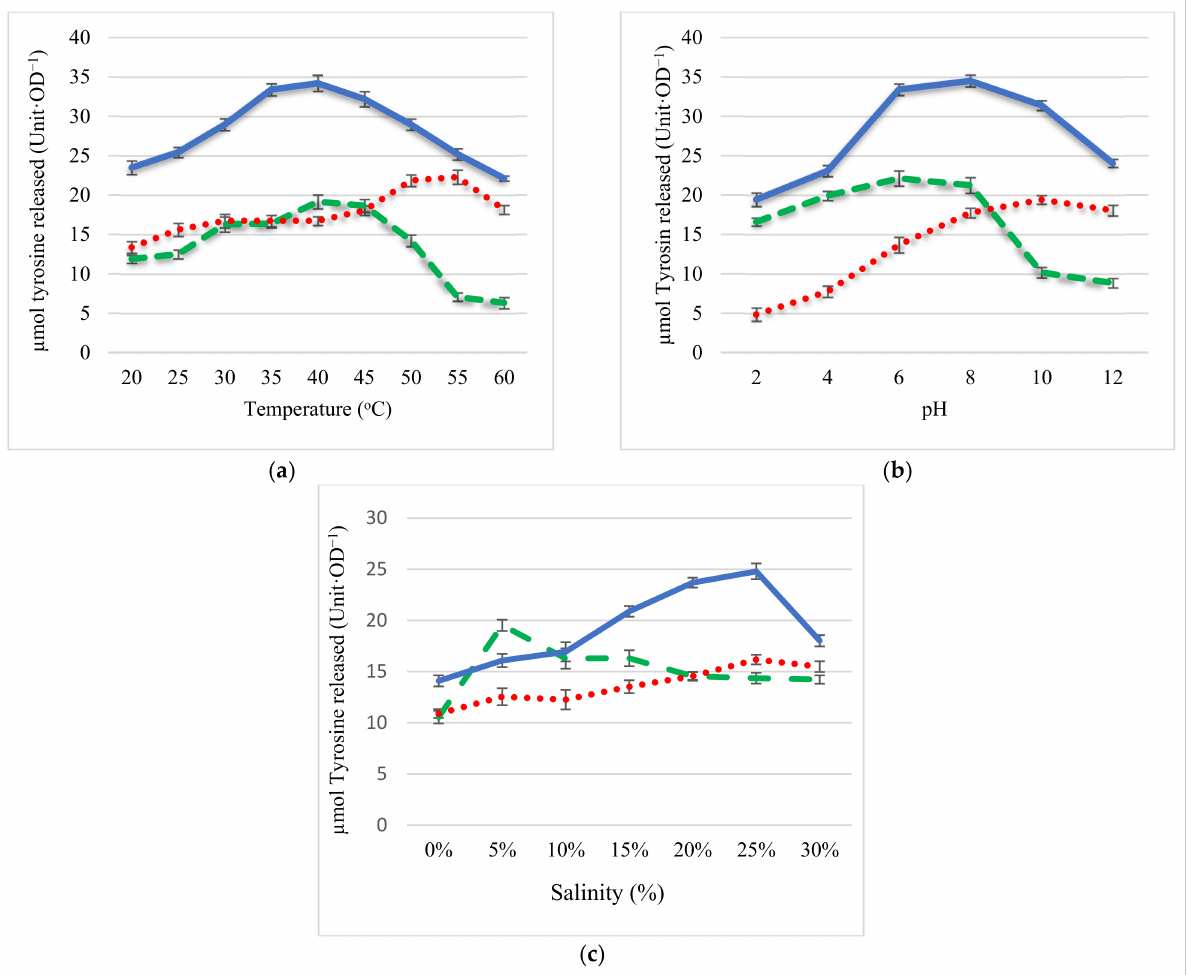
Figure 2. Effect of temperature ( a ), pH ( b ), and salinity ( c ) on Marinirhabdus sp., Marinobacter sp., and coculture protease activity. Solid line—co-culture; dashed line (- - - -)— Marinirhabdus sp.; dotted line ( ···· )— Marinobacter sp., pH was determined at 37 ◦ C in different buffers by varying pH values (pH 2–12; temperature was determined by assessing protease activity at different temperatures (20–60 ◦ C); salinity was investigated in the range of 0 to 30% at 37 ◦ C, pH 7.5. Results represent the means of three experiments, and bars indicate ± standard